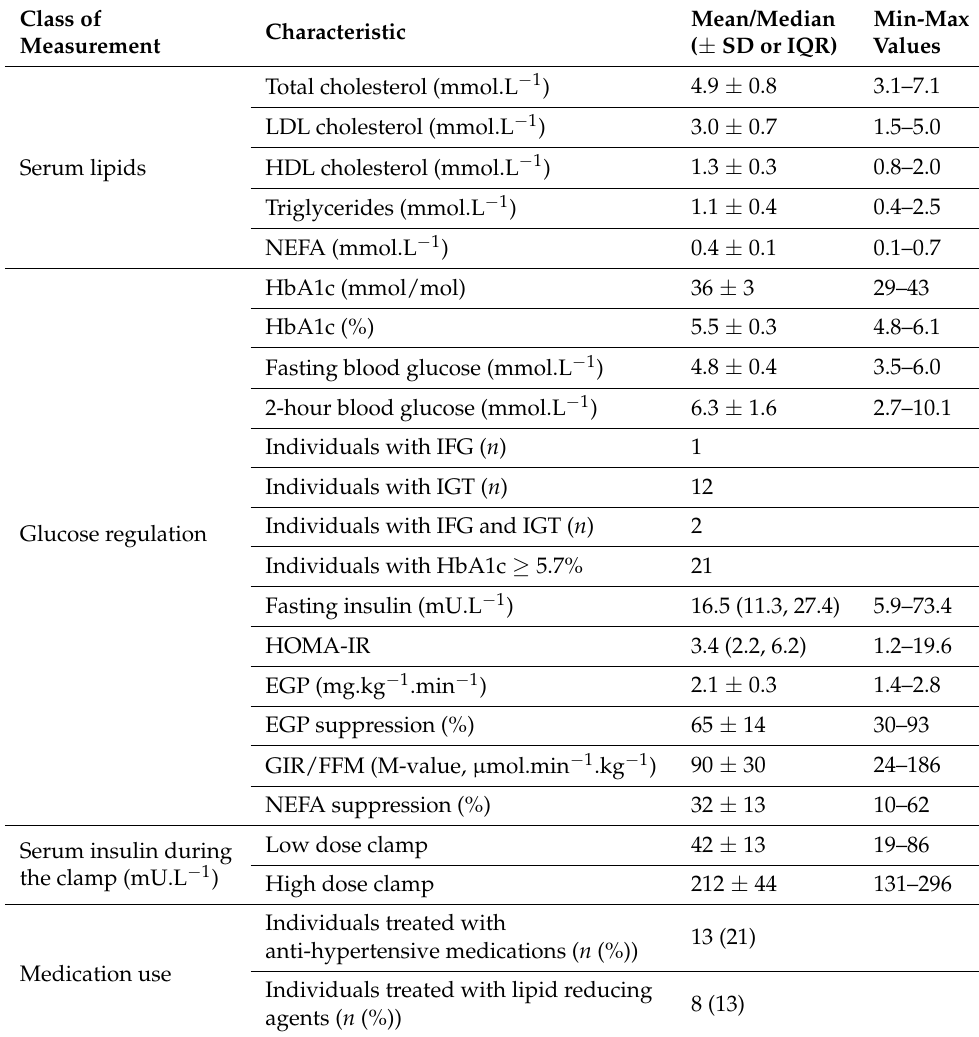
Table footnotes: Values are mean ± SD or median (25th, 75th percentile) and minimal to maximal. Complete data were available for all variables other than the abdominal MRI data ( n = 59; variables affected: visceral fat, subcutaneous fat and liver fat). Impaired fasting glucose (IFG) 5.6–6.9 mmol/L; impaired glucose tolerance (IGT) 2-h plasma glucose during OGTT (75-g glucose) 7.8–11.0